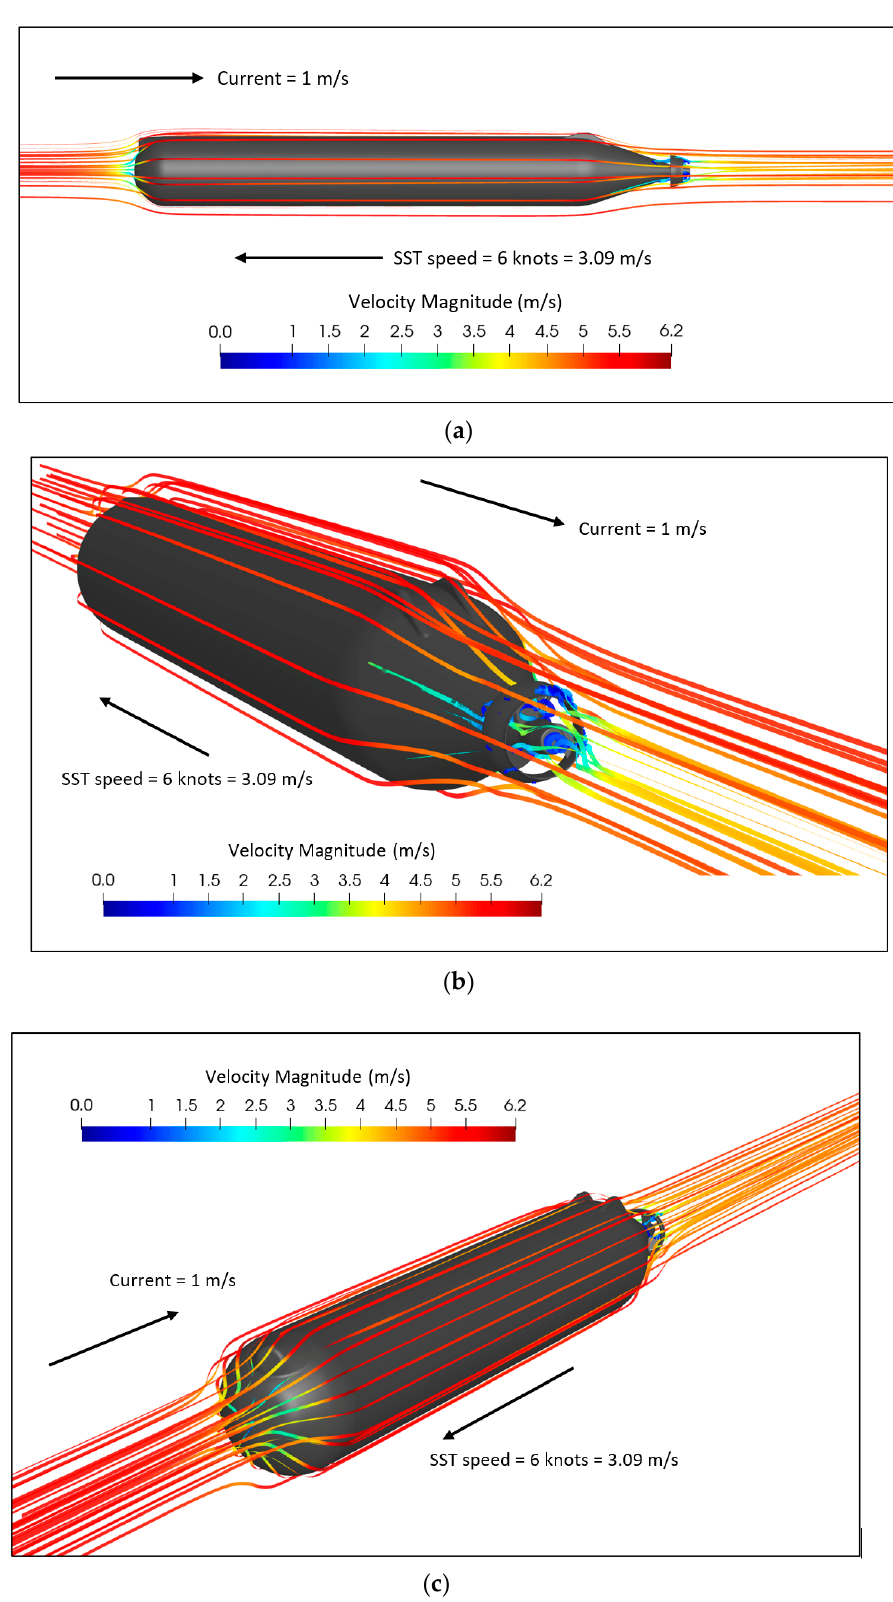
Figure 14. Streamlines around the SST hull colored by the flow velocity magnitude: ( a ) side view, ( b ) isometric view from the front, and ( c ) isometric view from the back.